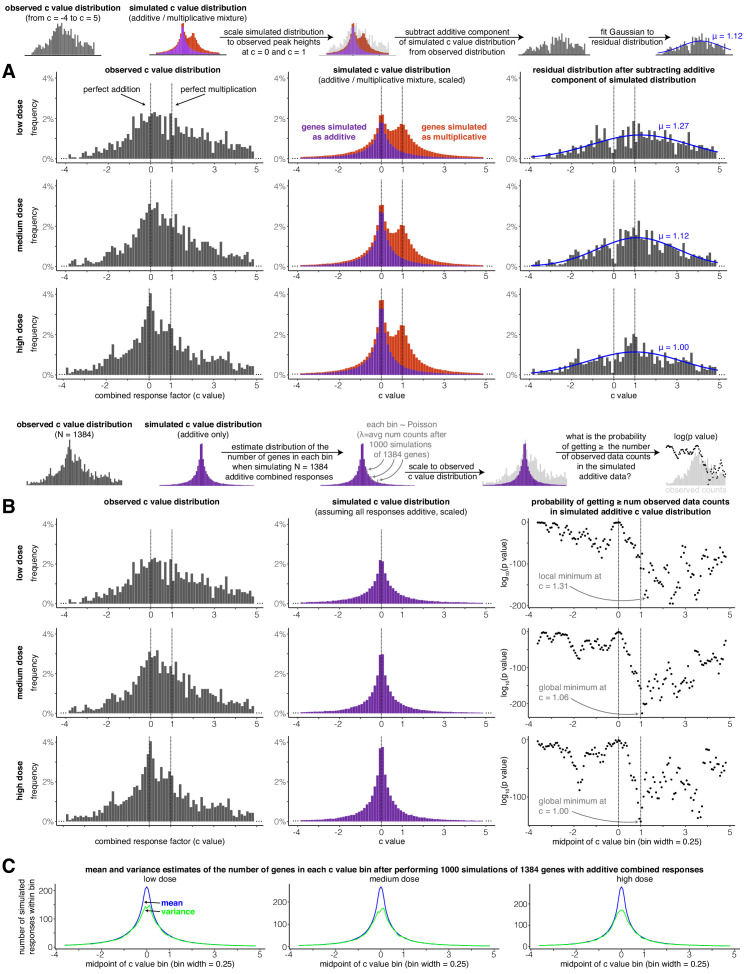
A secondary peak occurs at or near perfectly multiplicative combined transcriptional responses (c = 1) after subtracting a distribution of simulated additive responses from the observed distribution of c values.(A) For each dose, the observed c value distribution (in the range from c = −4 to c = 5), simulated c value distribution when transcriptional responses are assumed to be either additive or multiplicative, and residual distributions after the additive component of the simulated data is subtracted. Blue lines illustrate the best-fit Gaussian to the residual distribution (see Materials and methods for details). (B) At each dose, a c value distribution generated by simulated additive responses is matched to the height of the peak at c = 0 in the observed data. Then, the probability of witnessing the number of combined responses in each of the bins in the observed histogram is estimated under the null model that all combined responses are additive. Due to the limits of computational power and the extremely low probabilities of witnessing the number of observations as the bins move further away from c = 0, we assumed Poisson distribution was descriptive of the number of simulated observations that lied in a given c value bin (this assumption is justified by panel C, where the mean and variance of the number of simulated responses in each bin are nearly identical outside the narrow range of −0.3 < c < 0.3). (C) At each dose, the mean and variance of the number of simulated additive c values found in each c value bin.